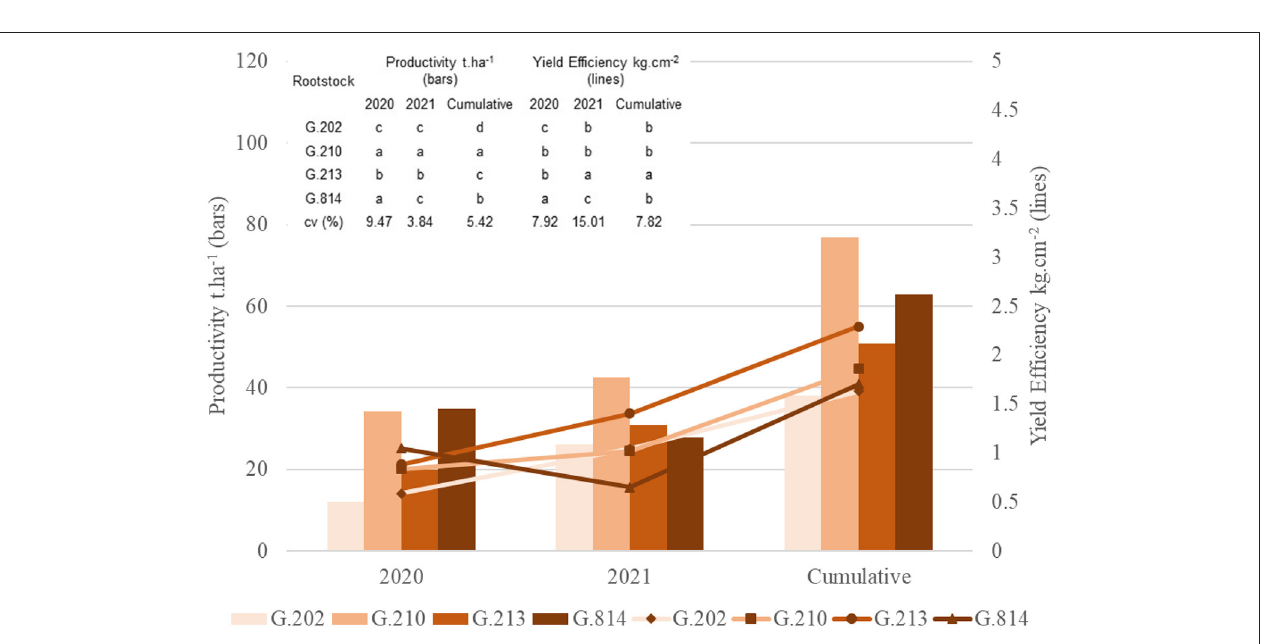
FIGURE 2 | Yield and yield efficiency of the Fuji Suprema cultivar grafted on different rootstocks, under replanting area in São Joaquim. Yield and yield efficiency that do not share a letter are significantly different (Tukey’s test, α =